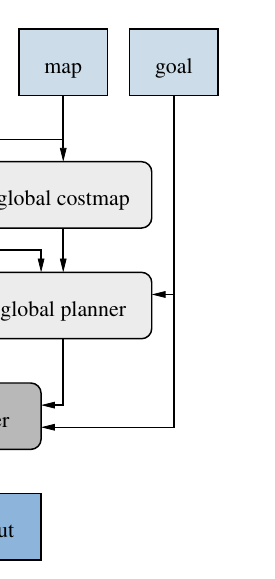
Figure 2. Overview of the different components of the localization, navigation and planning system and their